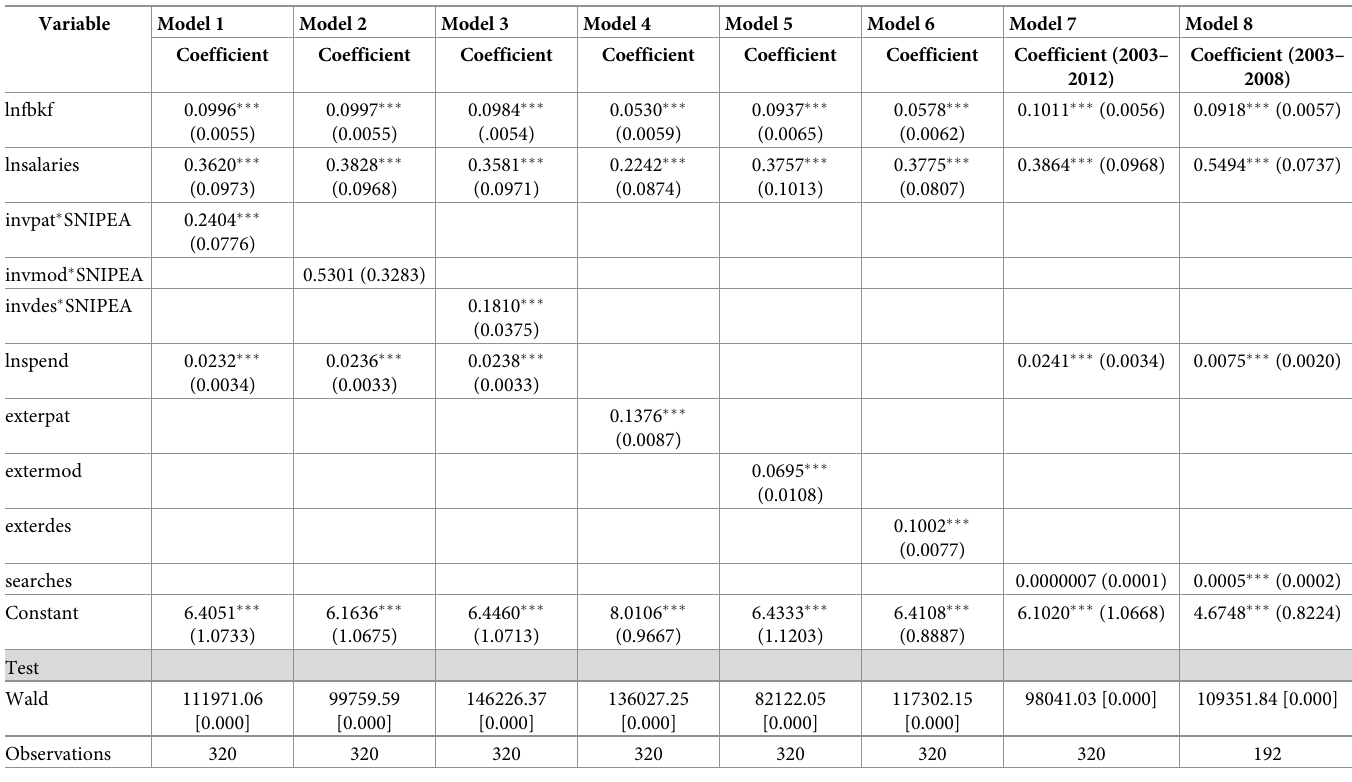
Table 4. Fixed effects estimates with FGLS heterskedasticity